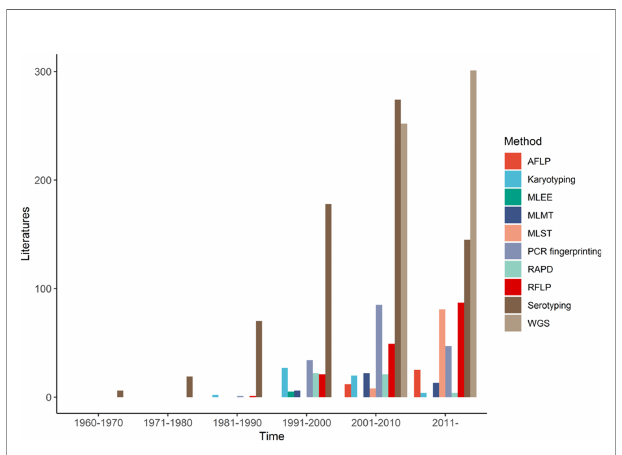
FIGURE 1 | Number of publications using different molecular typing methods for studying the human pathogenic Cryptococcus from 1960 to 2021, by